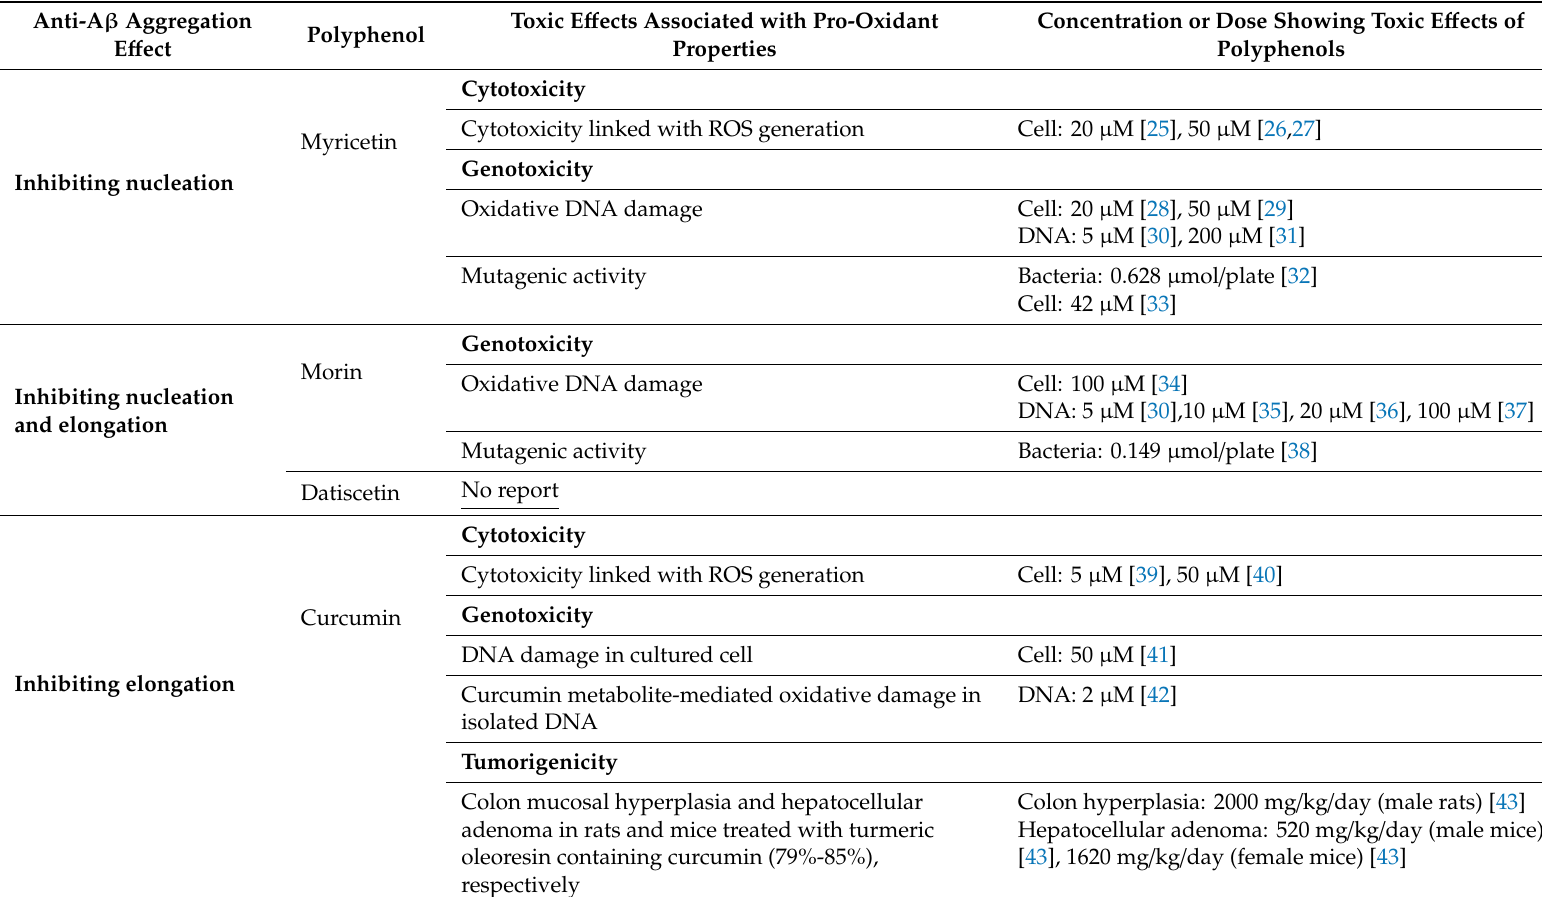
Table 1. Toxic e ff ects associated with pro-oxidant properties of naturally occurring polyphenols harboring anti-A β aggregation